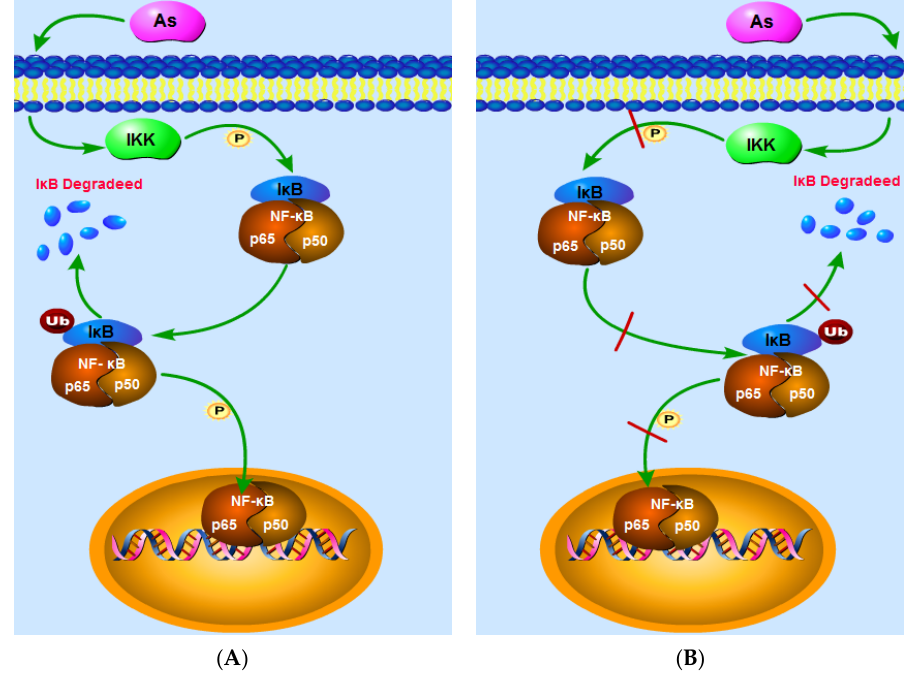
Figure 14. The NF ‐κ B signaling pathway. ( A ) shows that at high doses, the action of IKK